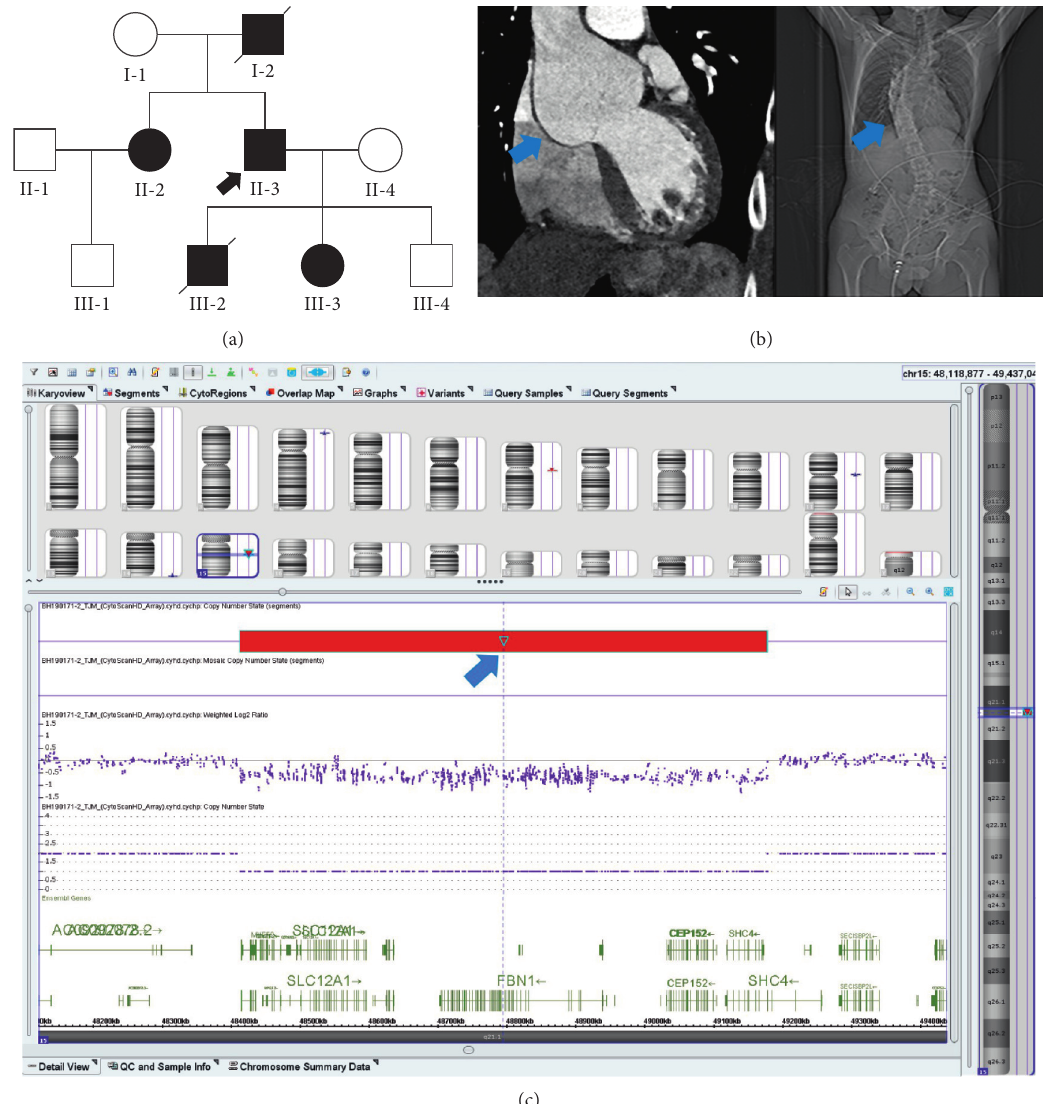
Figure 1: Investigation of 15q21.1 microdeletion pathogenicity. (a) Pedigree of family carrying the heterozygous 15q21.1 microdeletion. Full and open circles and squares indicate MFS patients and normal females and males, respectively. Patient II-2 was diagnosed with MFS and atrial septal defect. The proband is marked by a black arrow. Patients I-2 and III-2 with diagonal lines represent dead. Patients II-2, II-3, and III-3 carried the heterozygous CNV. (b) The blue arrows show the proband presenting with aortic aneurysm (left) on a CTA of the thoracic aorta and scoliosis (right) of the thoracolumbar spine on a radiograph. (c) The pathogenetic 15q21.1 microdeletion confirmed by CMA. In the blue frame is chromosome 15, and the red bar shows the deletion area. The deletion cite of CNV is Chr 15: